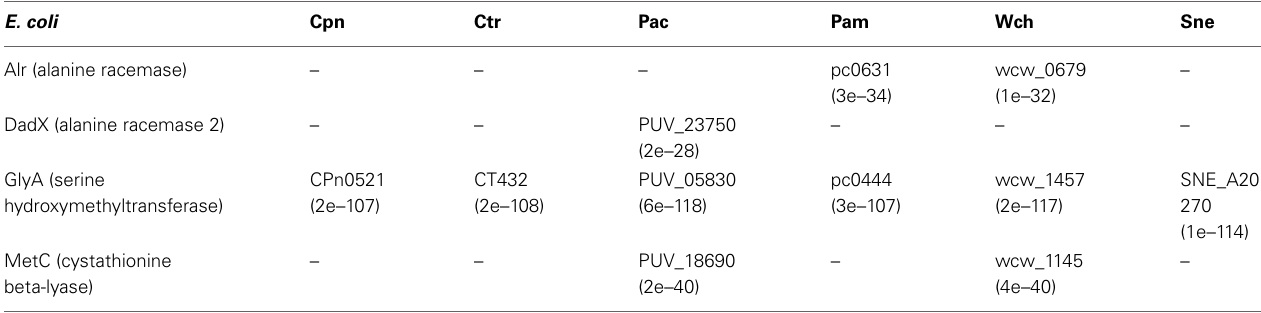
Locus tags of genes coding for enzymes involved in biosynthesis of D-Ala are shown for two exemplary Chlamydiaceae and for environmental chlamydiae